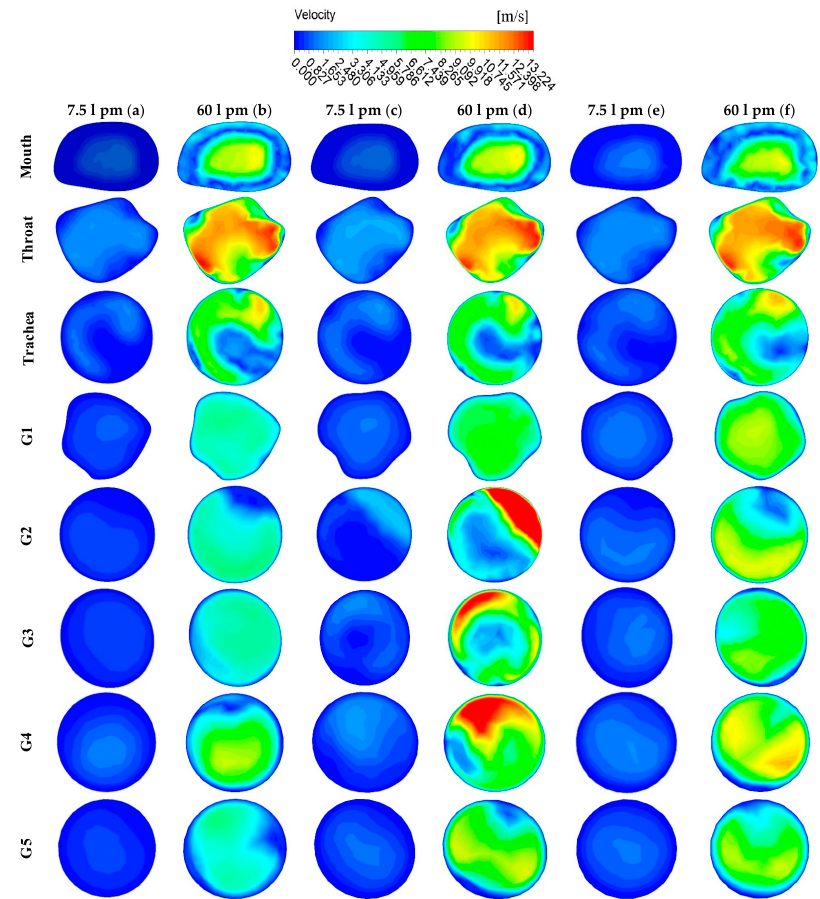
Figure 5. Velocity contours at selected positions of the upper airways, ( a ) 50-year-old, 7.5 L/min, ( b ) 50-year-old, 60 L/min, ( c ) 60-year-old, L/min, ( d ) 60-year-old, 60 L/min, ( e ) 70-year-old, 7.5 L/min, and ( f ) 70-year-old, 60 L/min. G1, Generation 1; G2, Generation 2; G3, Generation 3; G4, Generation 4; and G5, Generation 5. The comparison between flow rates at 7.5 L/min and 60 L/min showed significantly different velocity contours for the lower flow rate and the higher flow rate in all three lung age groups. Although the magnitude of velocity is different for the two flow rates, the velocity patterns remained similar in all three lung sizes. The maximum velocity in the